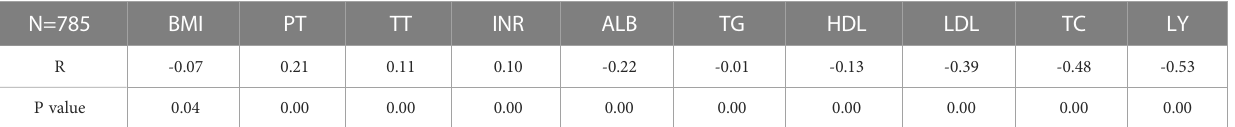
TABLE 2 CONUT scores and some clinical indicators show positive and negative correlations.